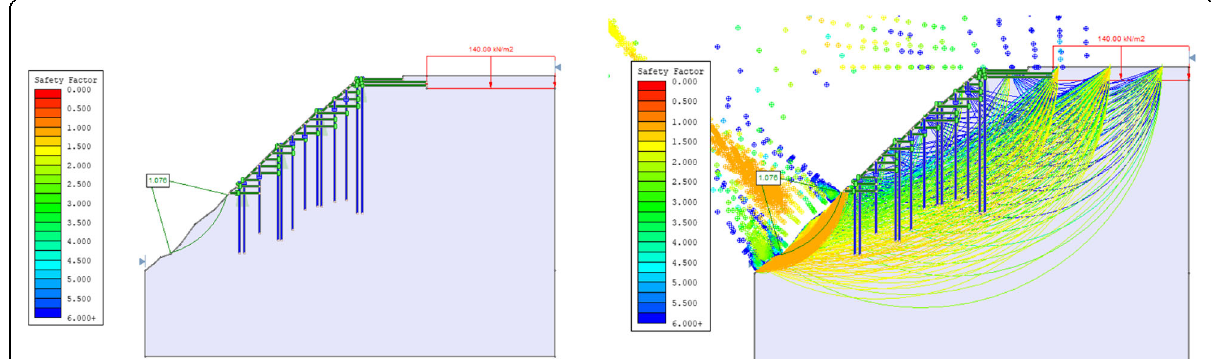
Fig. 14 In left, slip surface as per Bishops for overall fos of reinforced soil with micropile, geocell wall and geogrid, in right, slip surface as per Bishops for factor of safety of individual materials